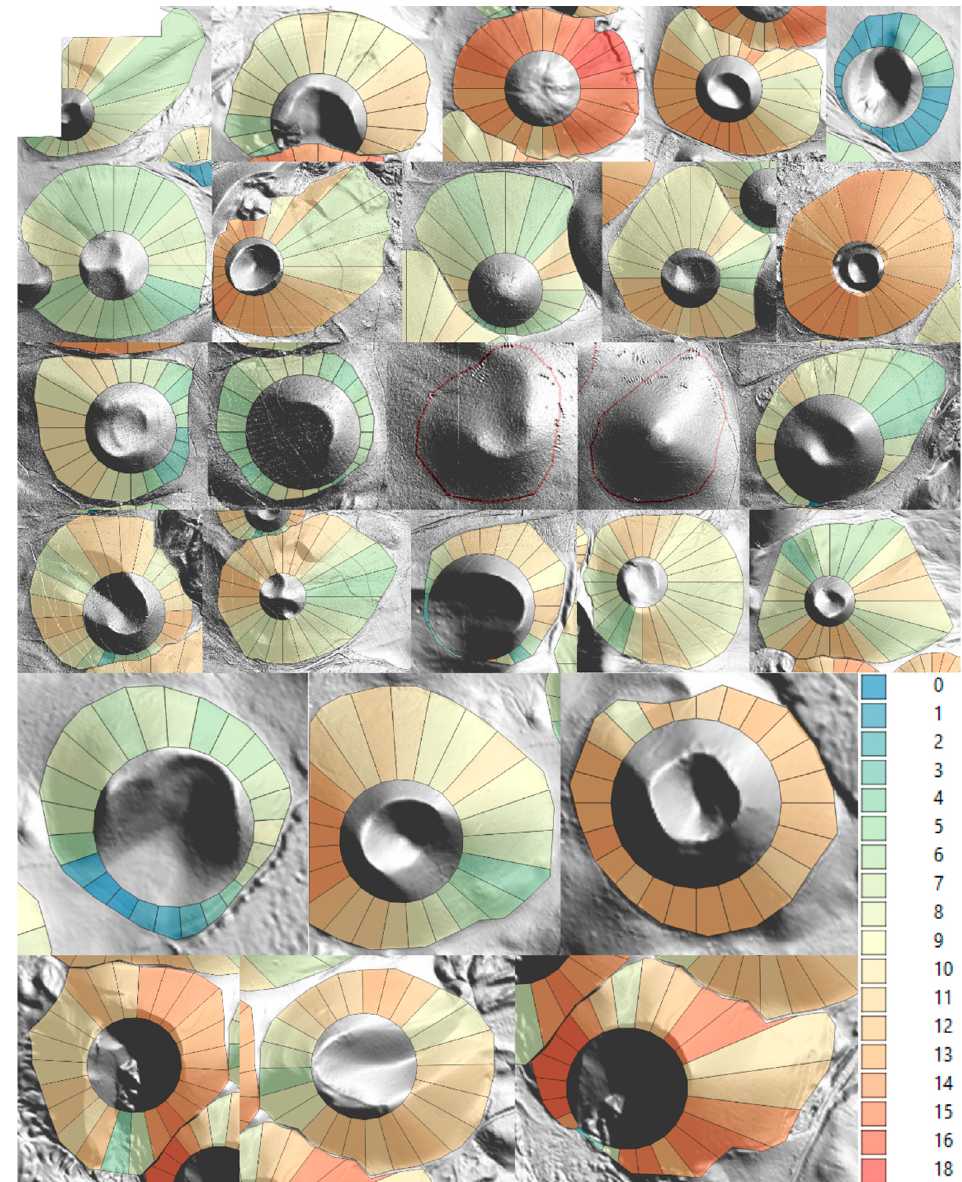
Figure 7. The examined 24 + 2 scoria cones in sectoral divisions. Values represent the groups derived from median values.